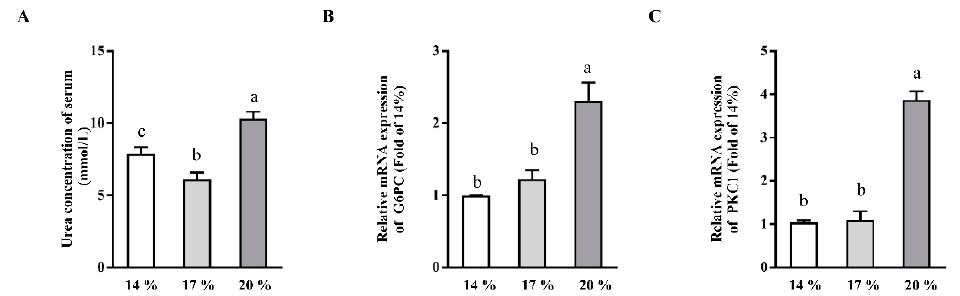
Figure 4. Effects of dietary crude protein level on serum urea concentration and hepatic gluconeo- genesis. Urea ( A ) concentration in serum, and G6PC ( B ) and PKC1 ( C ) mRNA abundance in the liver of weaned piglets fed different dietary crude protein. Values are means ± SEMs, n = 6. Means without a common letter differ, p < 0.05. G6PC, glucose-6-phosphatase catalytic subunit; PKC1, phosphoenolpyruvate carboxykinase 1.